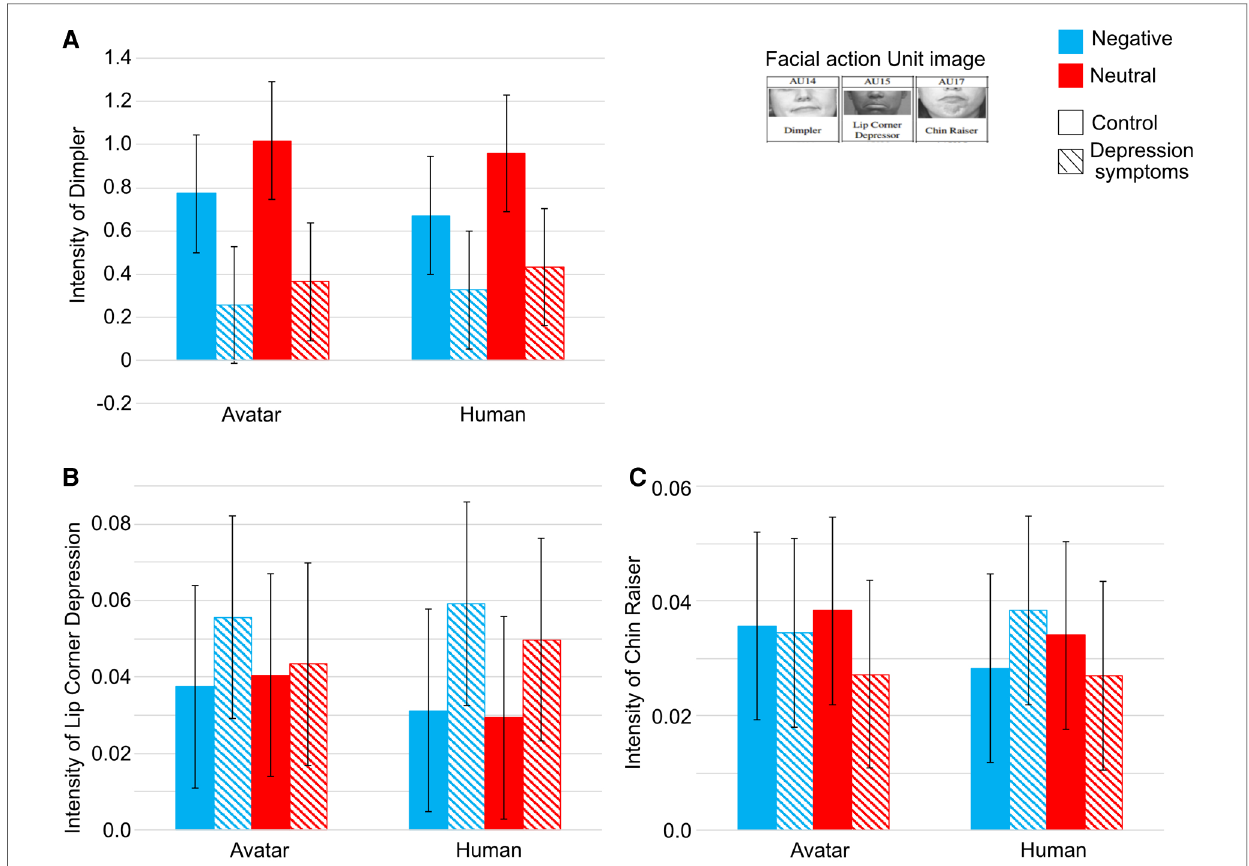
FIGURE 6 Intensity of ( A ) Dimpler ( B ) Lip Corner Depressor, and ( C ) Chin Raiser. Striped pattern boxes indicate the data of the depressed symptoms group, and solid boxes are the control group. Error bars indicate 95%